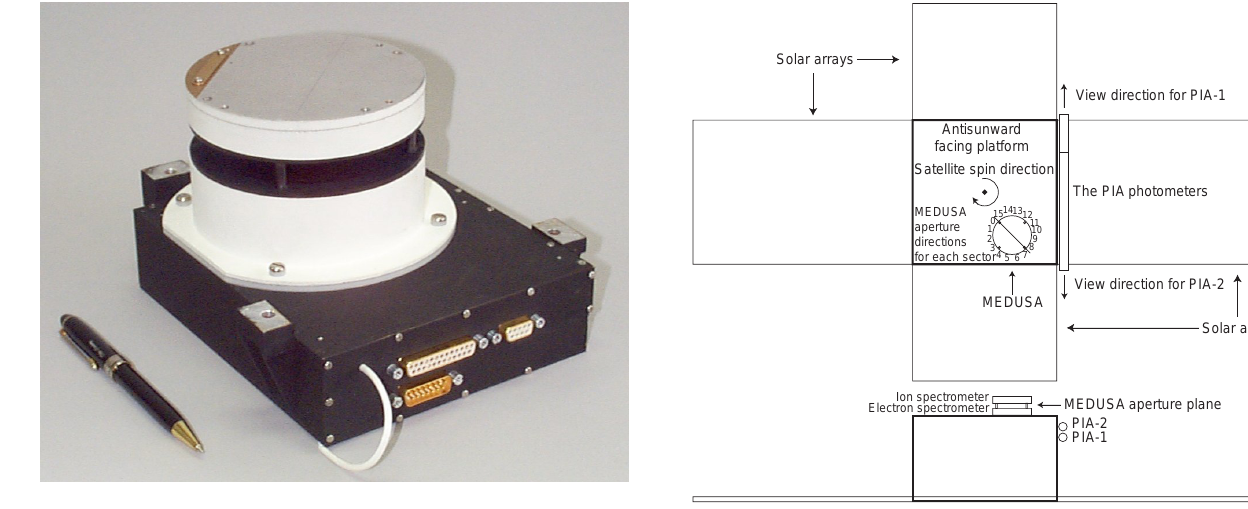
Fig. 1. The MEDUSA electron and ion spectrometer.